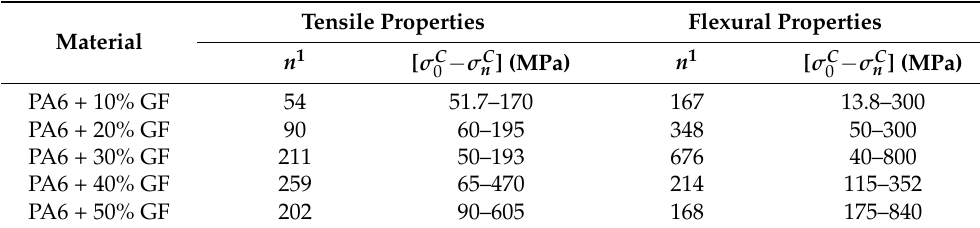
Table 2. Ranges spanned by the tensile and flexural strength properties of the